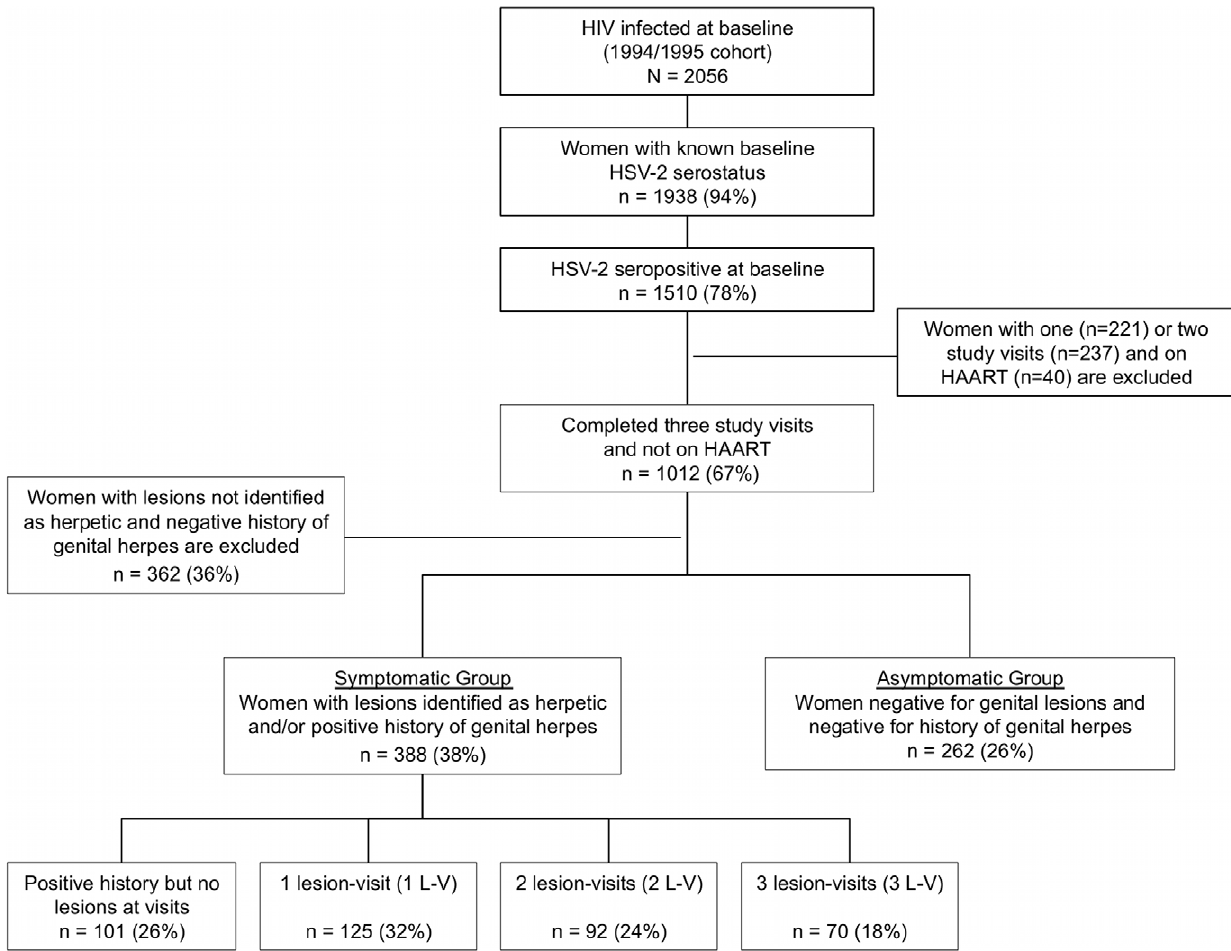
Figure 1. Flowchart of study participants and description of exposure groups.